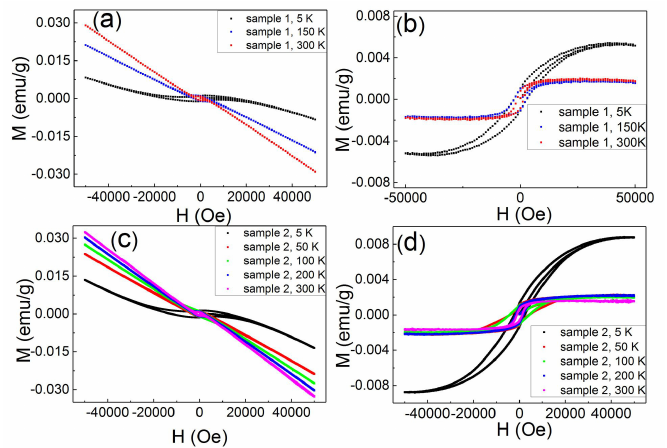
Figure 2. ( a , c ) The M–H curves at temperatures for sample 1 and sample 2. They exhibit hysteresis loops at low magnetic fields and diamagnetism at high magnetic fields. ( b , d ) The M–H curves at temperature for sample 1 and sample 2; the diamagnetic contribution was